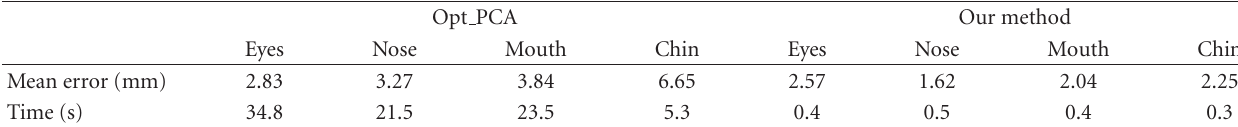
Table 4: Comparison of our method with the optimization approach. Each value is an average of ten trials with di ff erent example models.